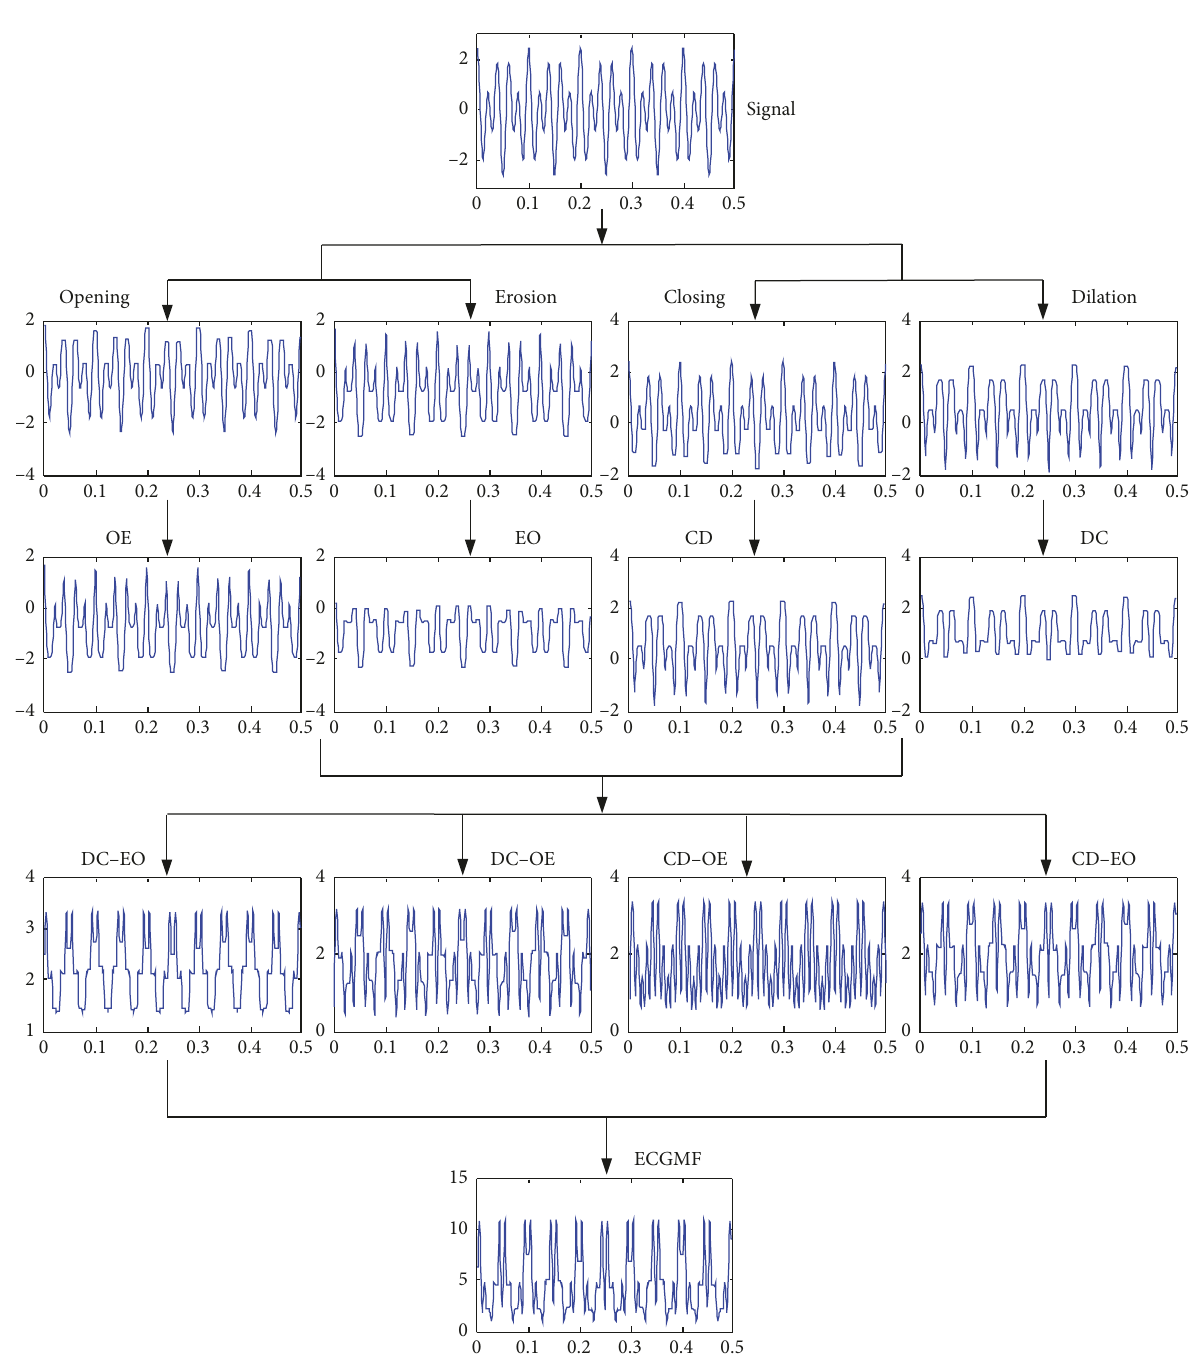
Figure 1: Process diagram of ECGMF